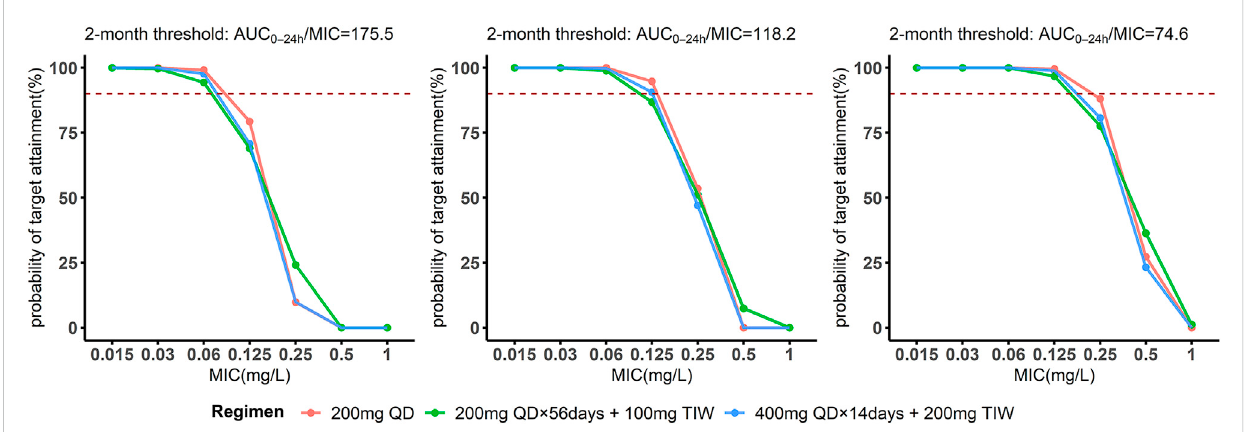
FIGURE 7 The probability of target attainment among the study participant from the validation cohort against varying 7H11 minimal inhibitory concentrations for bedaquiline. Probability of target attainment for bedaquiline taking the thresholds based on the 2-month, 6-month sputum conversion as well as successful treatment outcome as targets. The dashed lines indicate the 90% probability of target